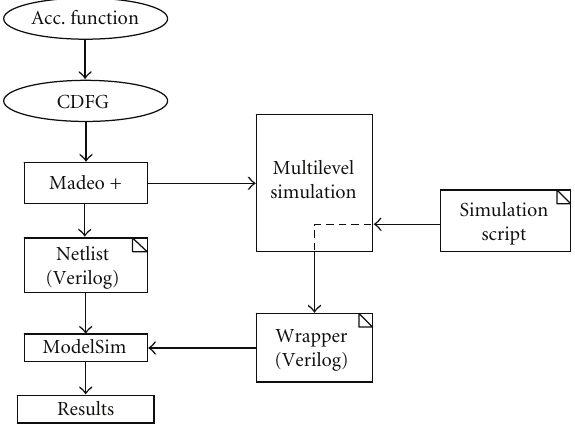
Figure 8: Simulation with generated wrapper and third party tool: